Question: What type of chart is this?
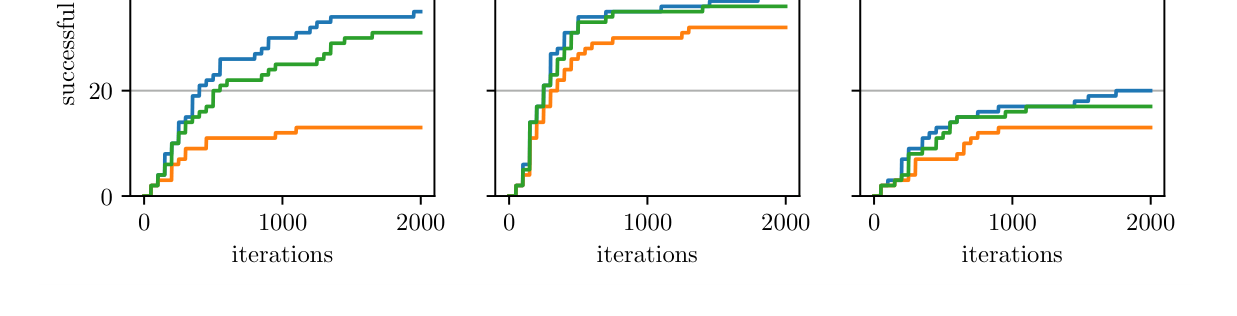
Answer: line